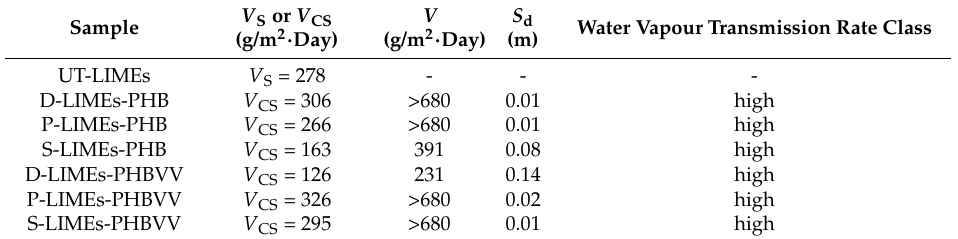
Table 10. Results of water vapour diffusion test for limestone treated with PHB and PHBVV and untreated.